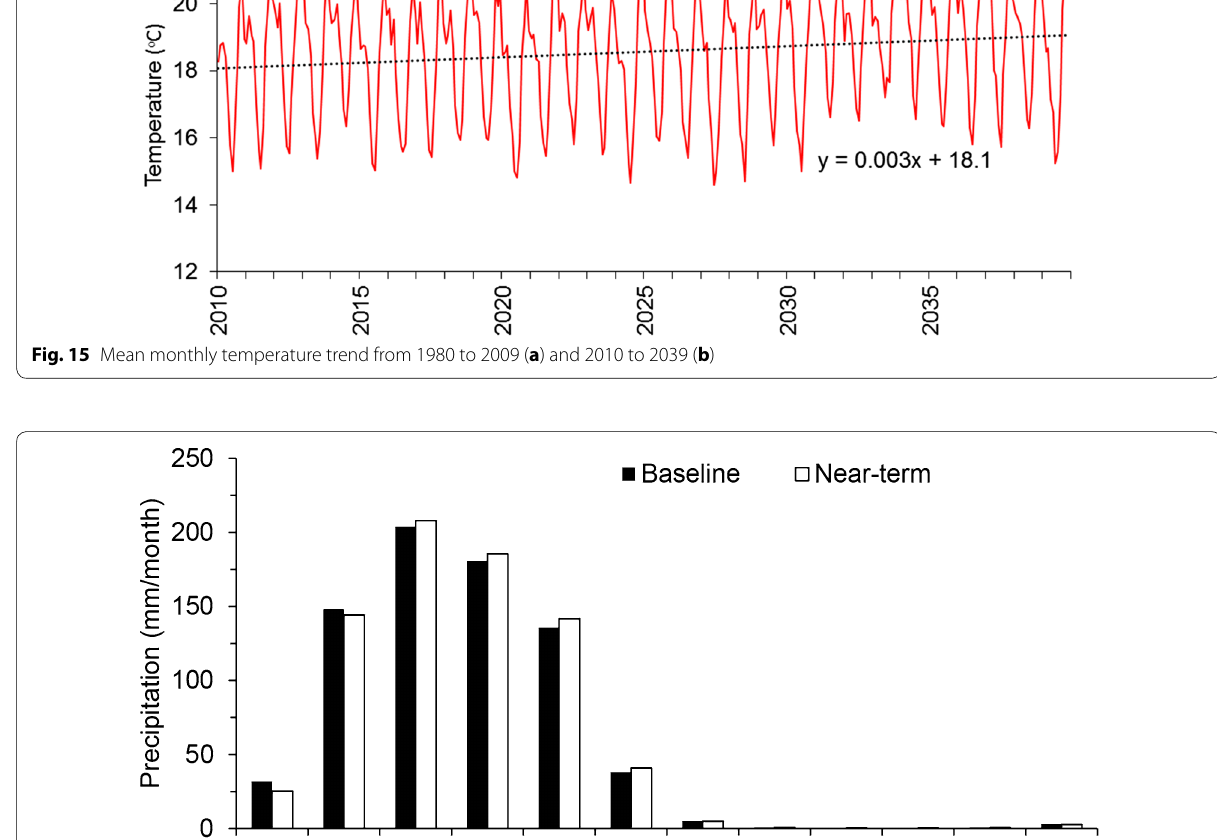
(Range-Grasses) showed a decrease of 6 and 1%, respec- tively. Very small changes were observed for urban land and